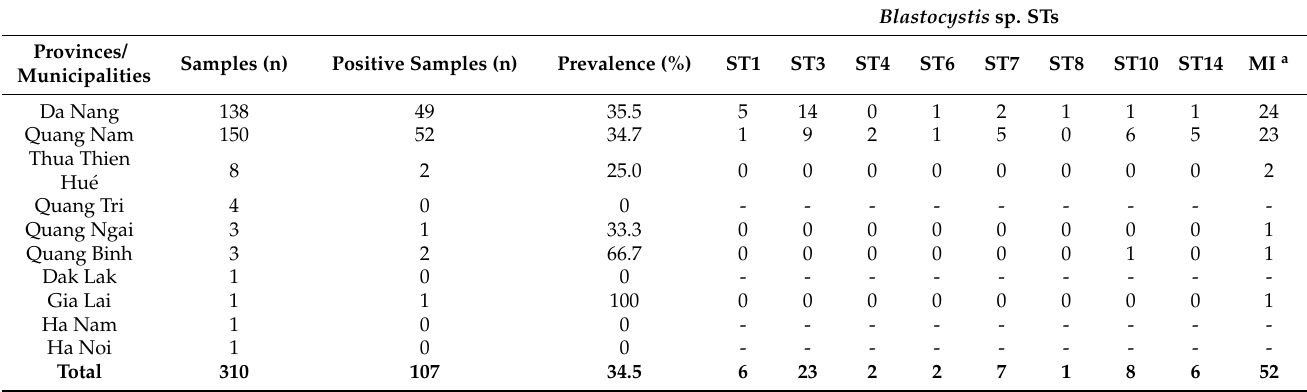
Table 1. Prevalence and ST distribution of Blastocystis sp. in the 10 Vietnamese provinces and municipalities screened in the present